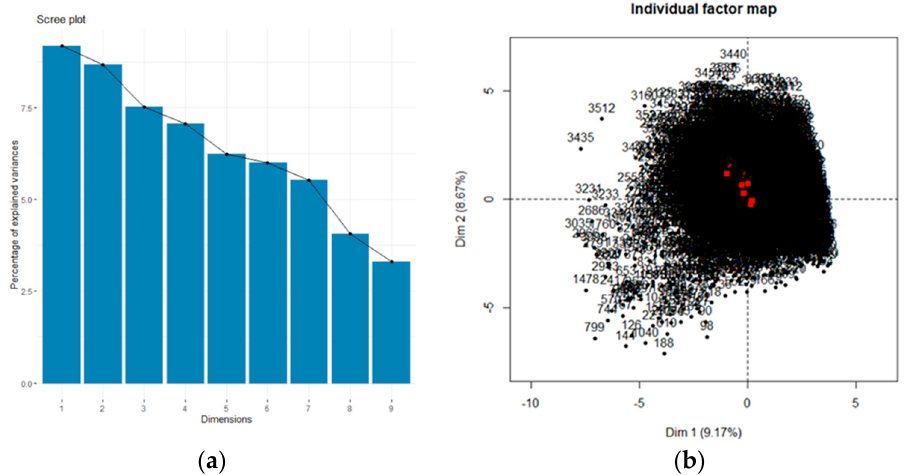
Children 2021 , 8 , 277 Figure A1. ( a,b ) Scree plot for each of the first 9 FAMD dimensions and individual factor map.